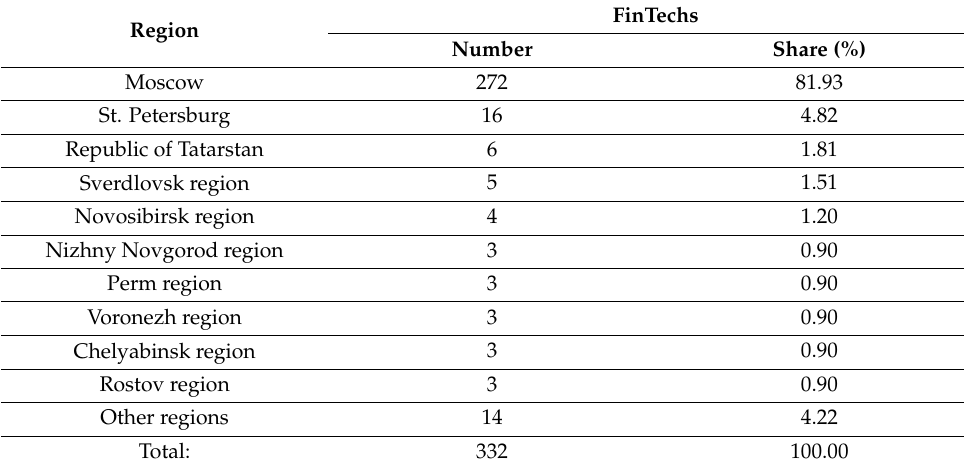
Table 3. The distribution of FinTechs across Russian regions.